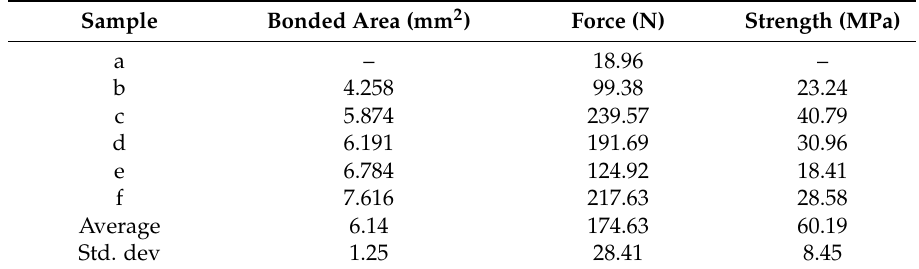
Figure 8. Scanning acoustic tomography (SAT) results of bonded die-chip samples, with greyed area showing bonded areas. Sample (a) was ignored in future tests due to its insufficient bonding area. Table 2. Shear testing done on die-chip samples. Force detected was divided by calculated area to obtain the shear strength. Sample (a) bonded area was too insignificant to be calculated.